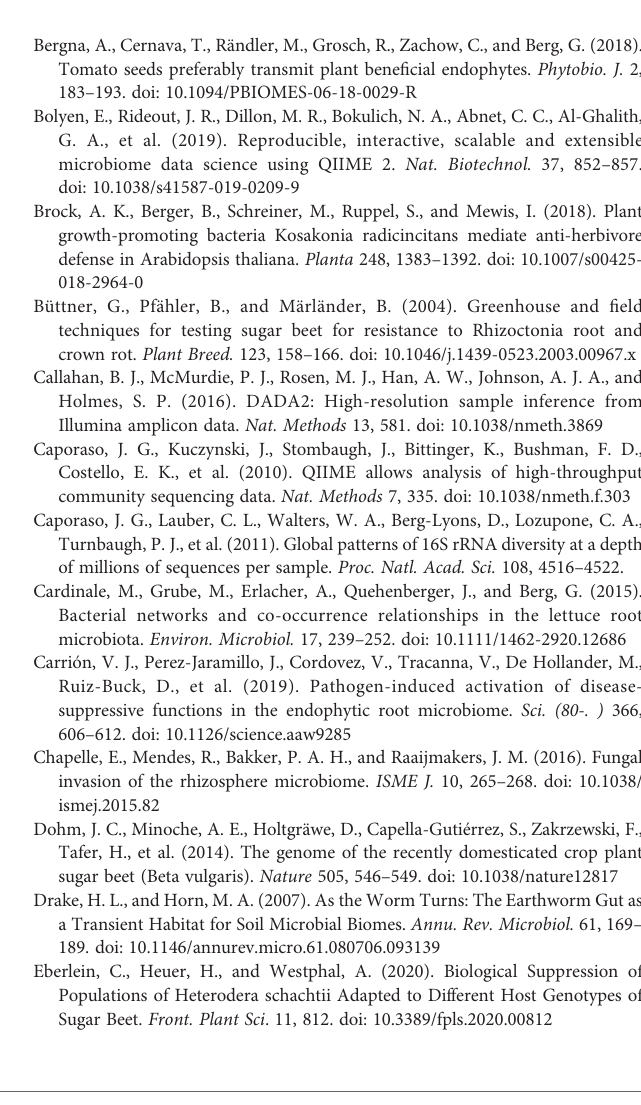
SUPPLEMENTARY FIGURE 1 | PCoA-biplots of sugar beet seed endophyte communities on genus level displaying Bray Curtis dissimilarities using PCoA axes 1 and 3 (A) , 1 and 4 (B) and 2 and 3 (C) . SUPPLEMENTARY FIGURE 2 | Results of fi eld trials for relative in-/decrease of Rhizoctoniadisease index (RI, according to Büttner et al., 2004), number of sugar beets andnumber of healthy sugar beets for the cultivarsBER, ISA and MAT using a consortium of three bacterial antagonists additionally to standard fungicide treatment. Results are relative to sugar beet seeds with standardfungicide treatment. Comparisons did not resultin signi fi cant differences but trendstowards stronger positive effects in the